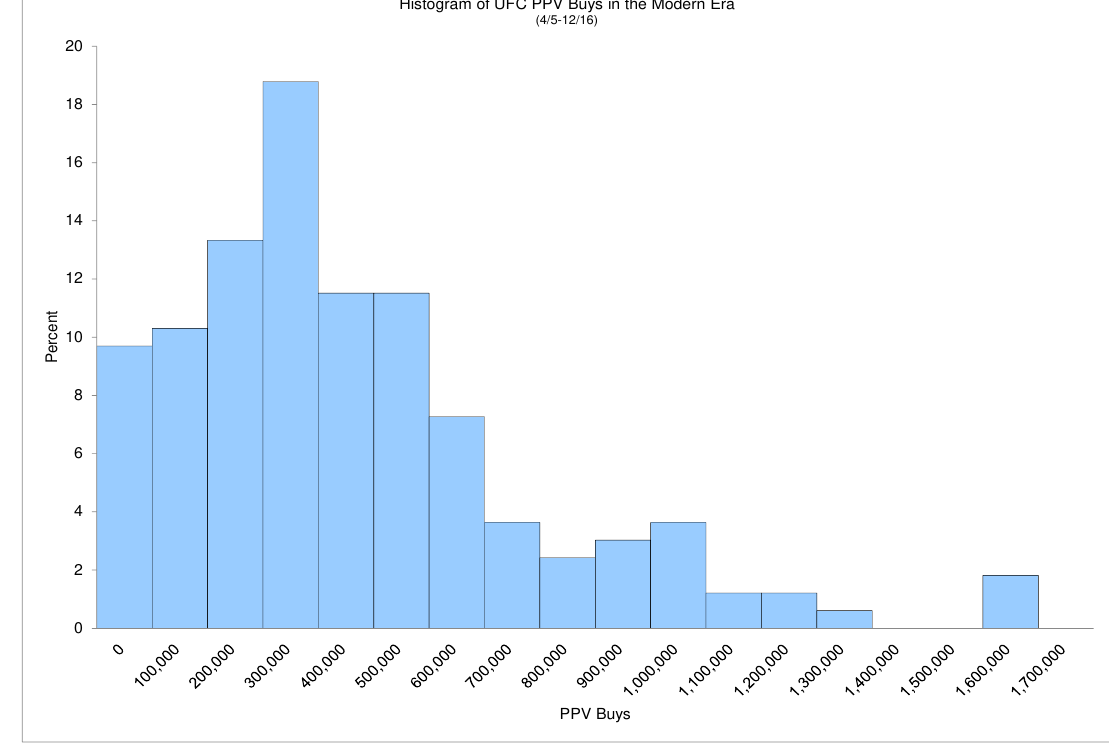
Fig. 4. Histogram of PPV buys